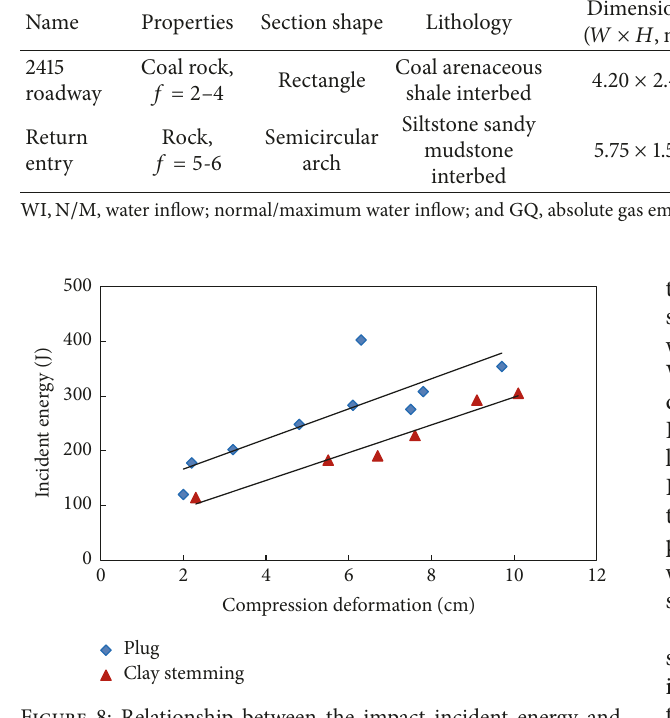
Figure 8: Relationship between the impact incident energy and compression